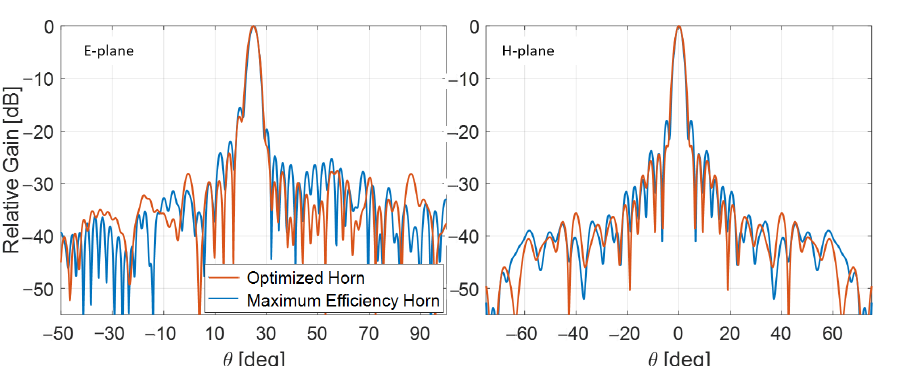
Figure 12. Radiation patterns in the E (left) and H (right) planes at 30 GHz for the configuration, using the optimized feed and that adopts a horn designed to maximize the entire antenna system, both evaluated at 30 GHz.